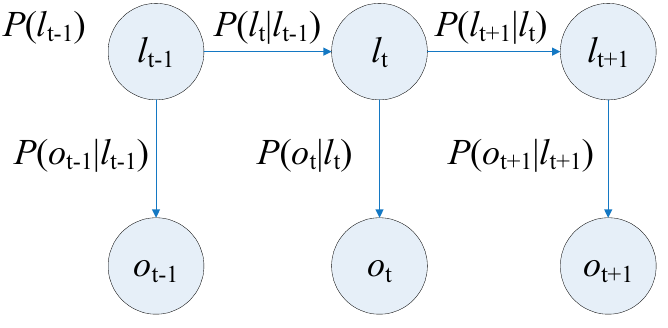
Figure 4. The architecture of the first-order HMM.